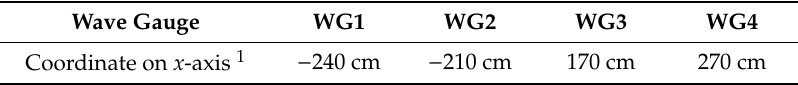
Table 1. The distances of wave gauges (WG) from the center of the